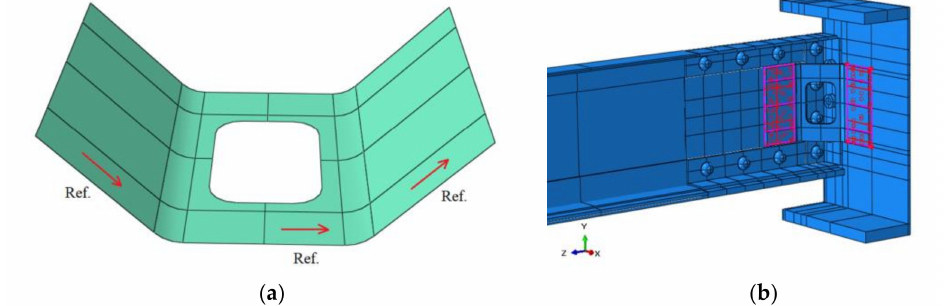
Figure 19. Definition of the CFRP in the local FE model. ( a ) CFRP reference orientation. ( b ) Tie constraints.